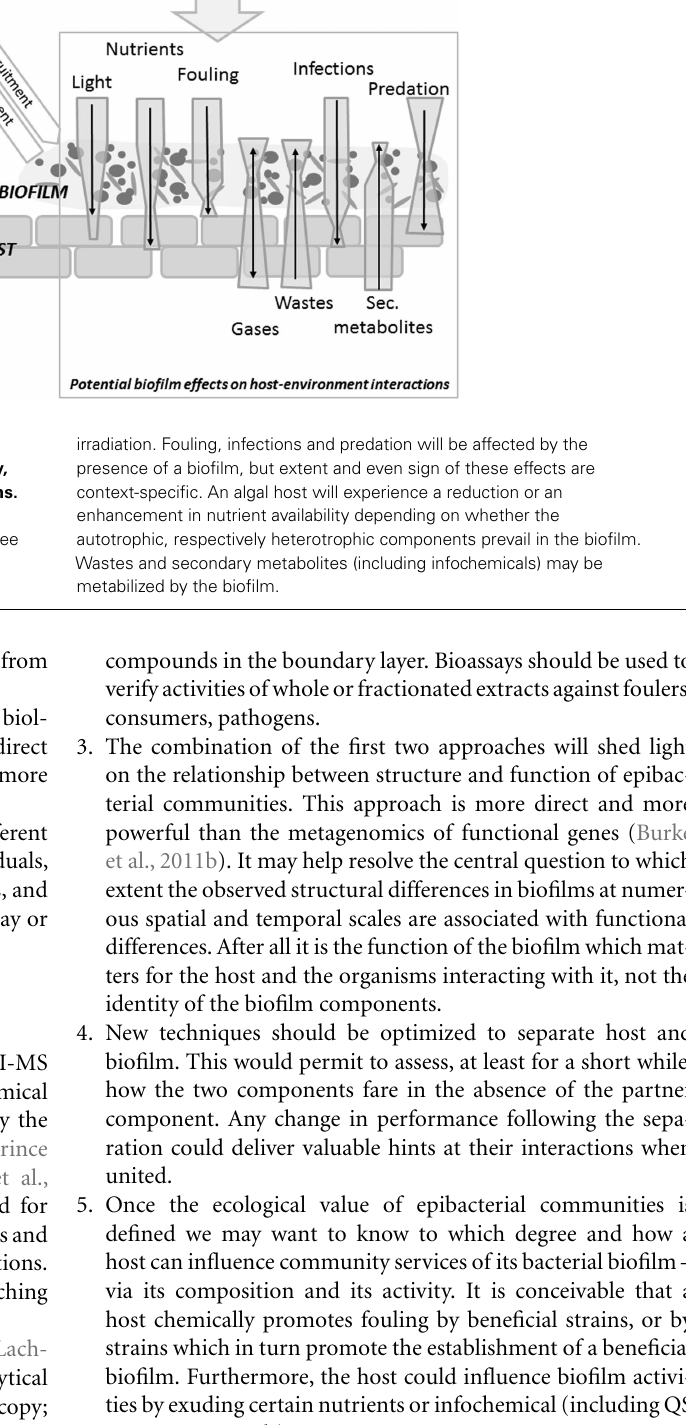
irradiation. Fouling, infections and predation will be affected by the presence of a biofilm, but extent and even sign of these effects are context-specific. An algal host will experience a reduction or an enhancement in nutrient availability depending on whether the autotrophic, respectively heterotrophic components prevail in the biofilm. Wastes and secondary metabolites (including infochemicals) may be metabilized by the